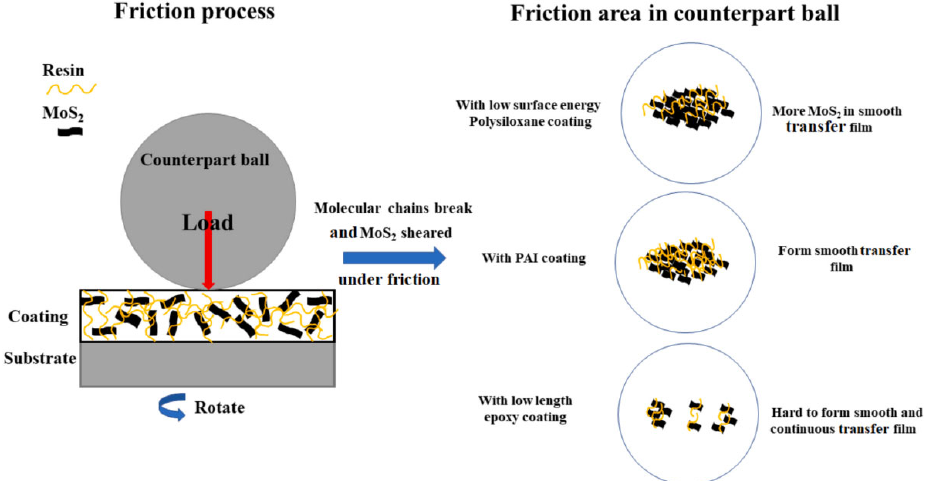
Fig. 20 Form process of transfer film in counterpart ball corresponding to three different lubricating coatings [237]. Reproduced with permission from Ref. [237], © Elsevier Ltd.,